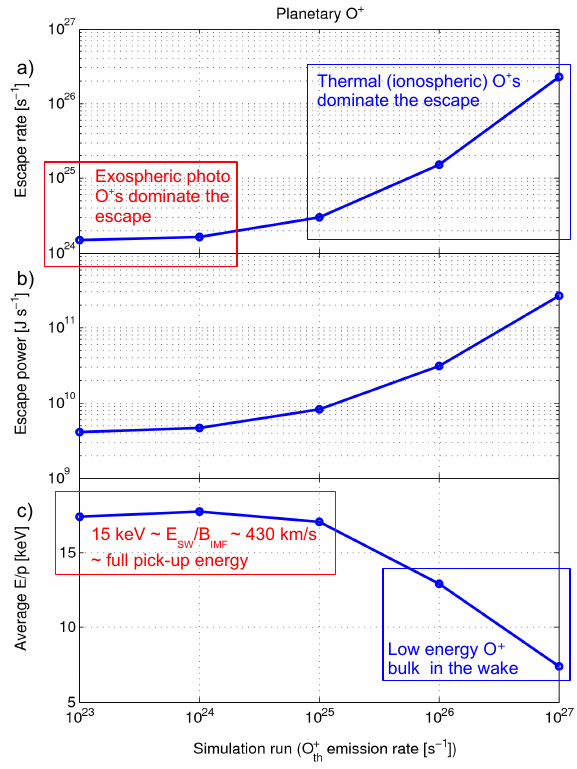
Fig. 10. Escape of the planetary O + particles in five HYB-Venus simulation runs with different O + emission rates. The x-axis is the th O + emission rate. The top panel shows the absolute O + escape th rate from the simulation box, the middle panel shows the rate of the O + kinetic energy escape from the box (the total O + escape power) and the bottom panel shows the average kinetic energy per escaping